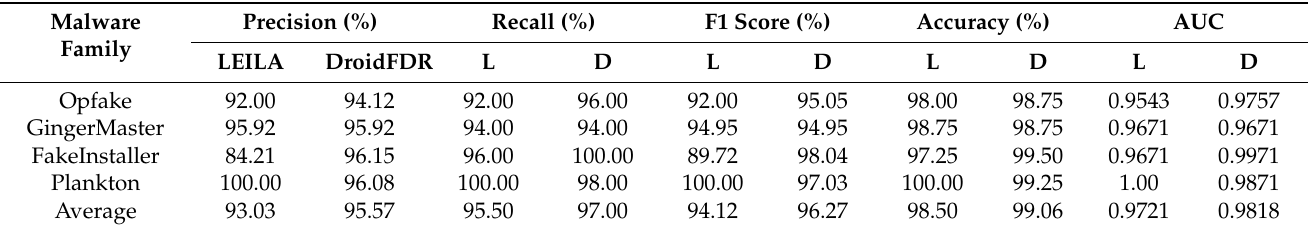
Table 2. Comparison of family classification results between LEILA and